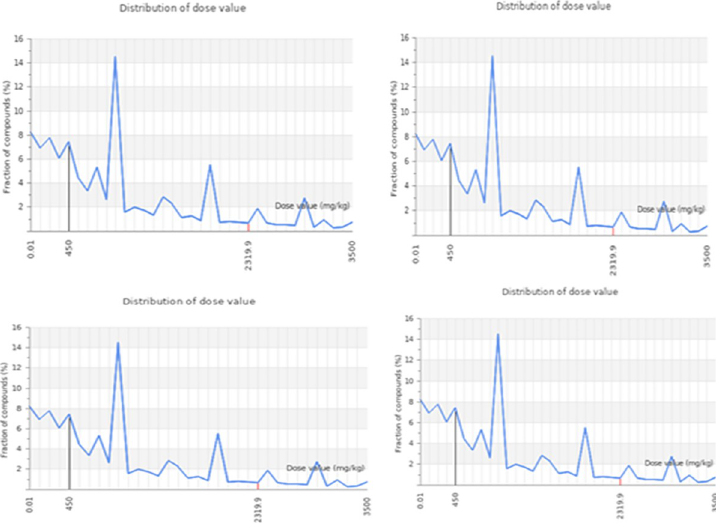
Fig 8. Graphical representation of predicted dose value distribution for D-alanine-D-alanine ligase. In this graph, x-axis represents distribution of dose value and y-axis represents fraction of